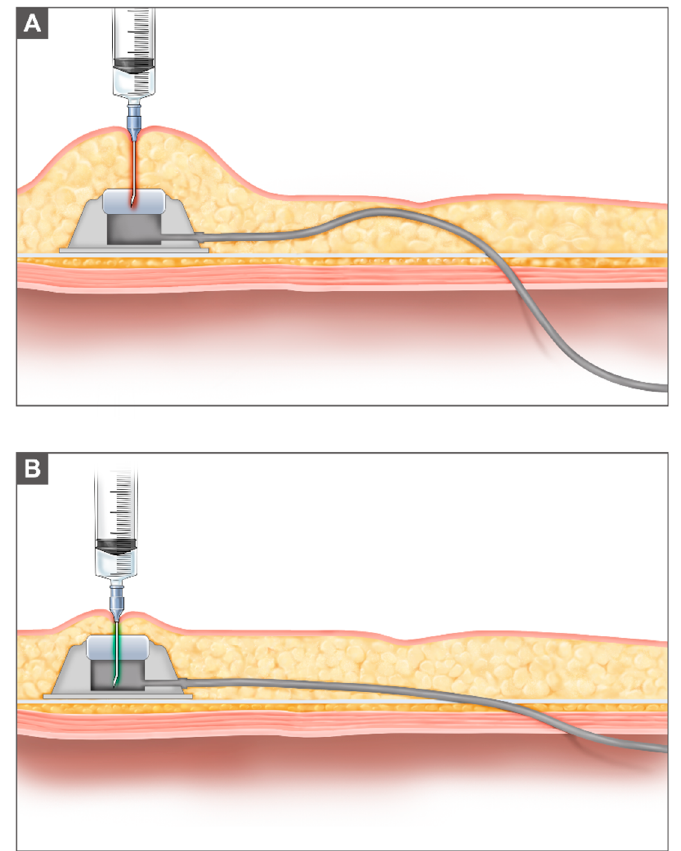
Figure 3. Placement of the IP port: ( A ) Prior to modification of the IP port insertion, the subcutaneous tissue on the IP port was not surgically reduced, and the IP port was inserted while upward retraction of abdominal wall was obtained using a Richardson retractor. Needling of the IP port was challenging because the subcutaneous tissue and tortuous insertion of the IP port line increased the risk of IP port obstruction. ( B ) After modification of the IP port insertion, the subcutaneous tissue on the IP port was surgically reduced for easy palpation and efficient needling of the IP port. The IP port line was straight onto the fascia and penetrated smoothly into the peritoneal cavity.